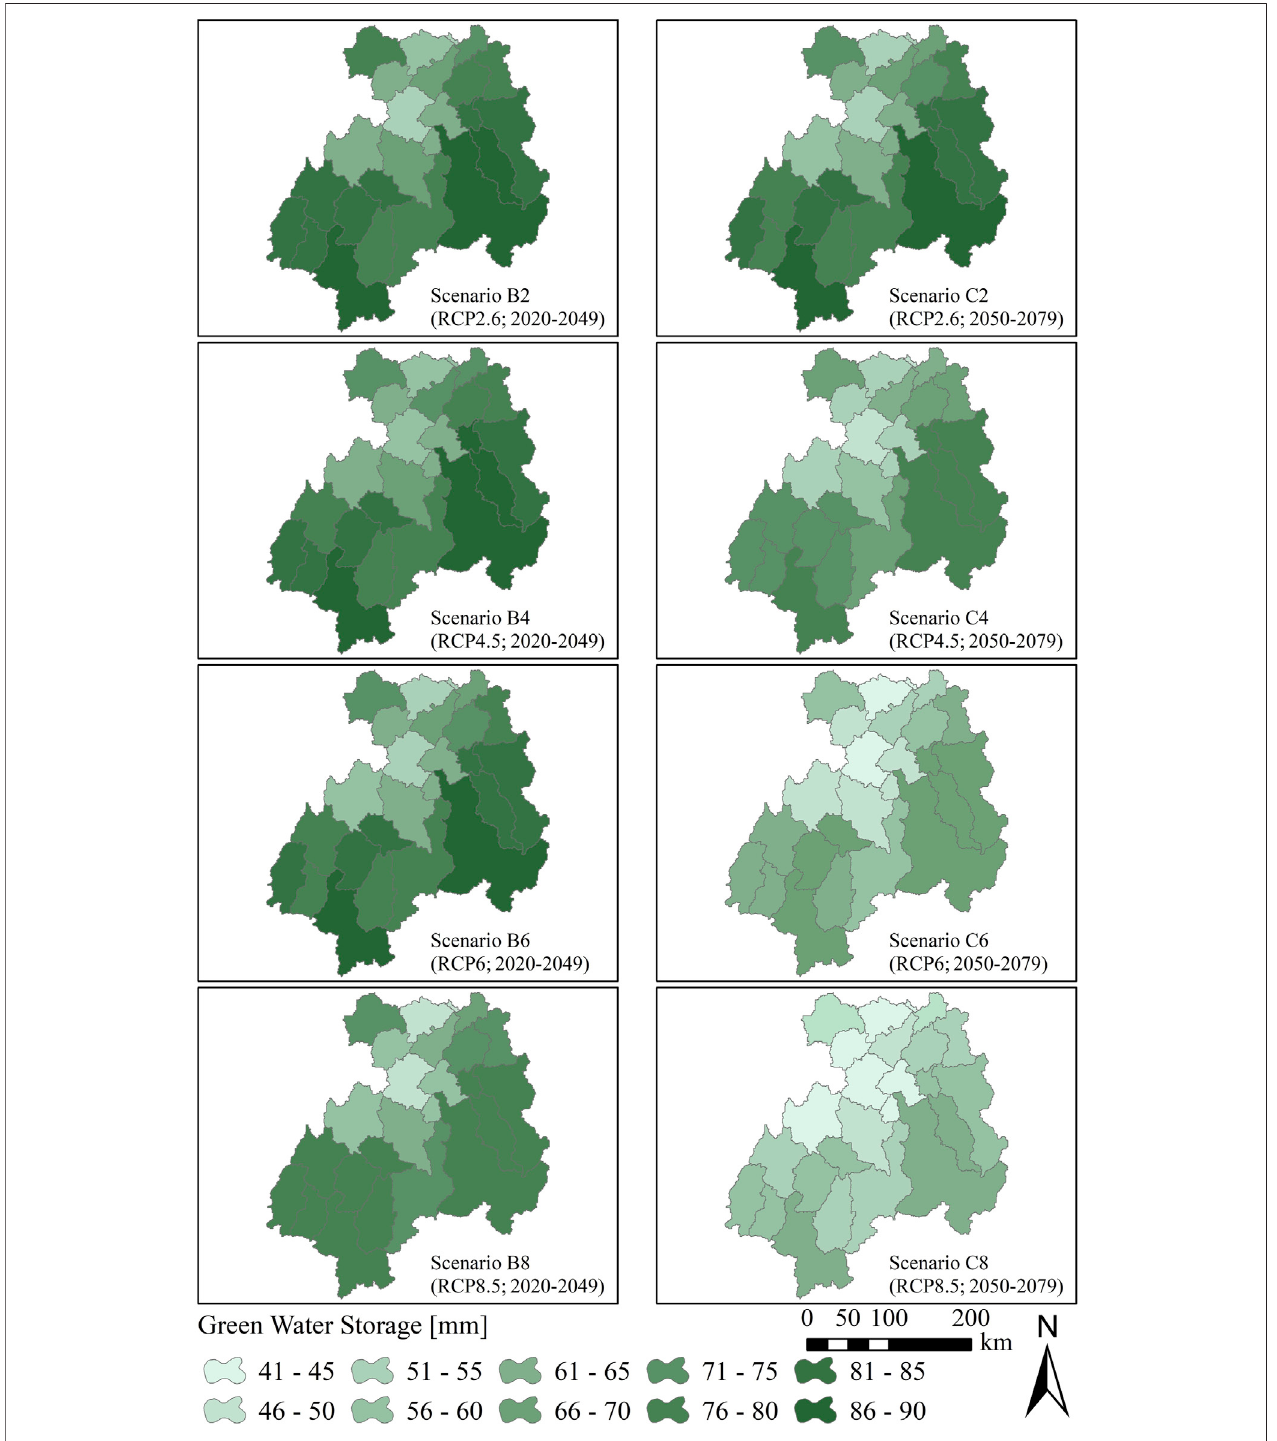
FIGURE 12 | Spatial distributions of the annual average green water storage (mm yr − 1 ) under different RCPs in future HadCM3 climate scenarios (2020 – 2079) in the Xiangjiang River Basin.